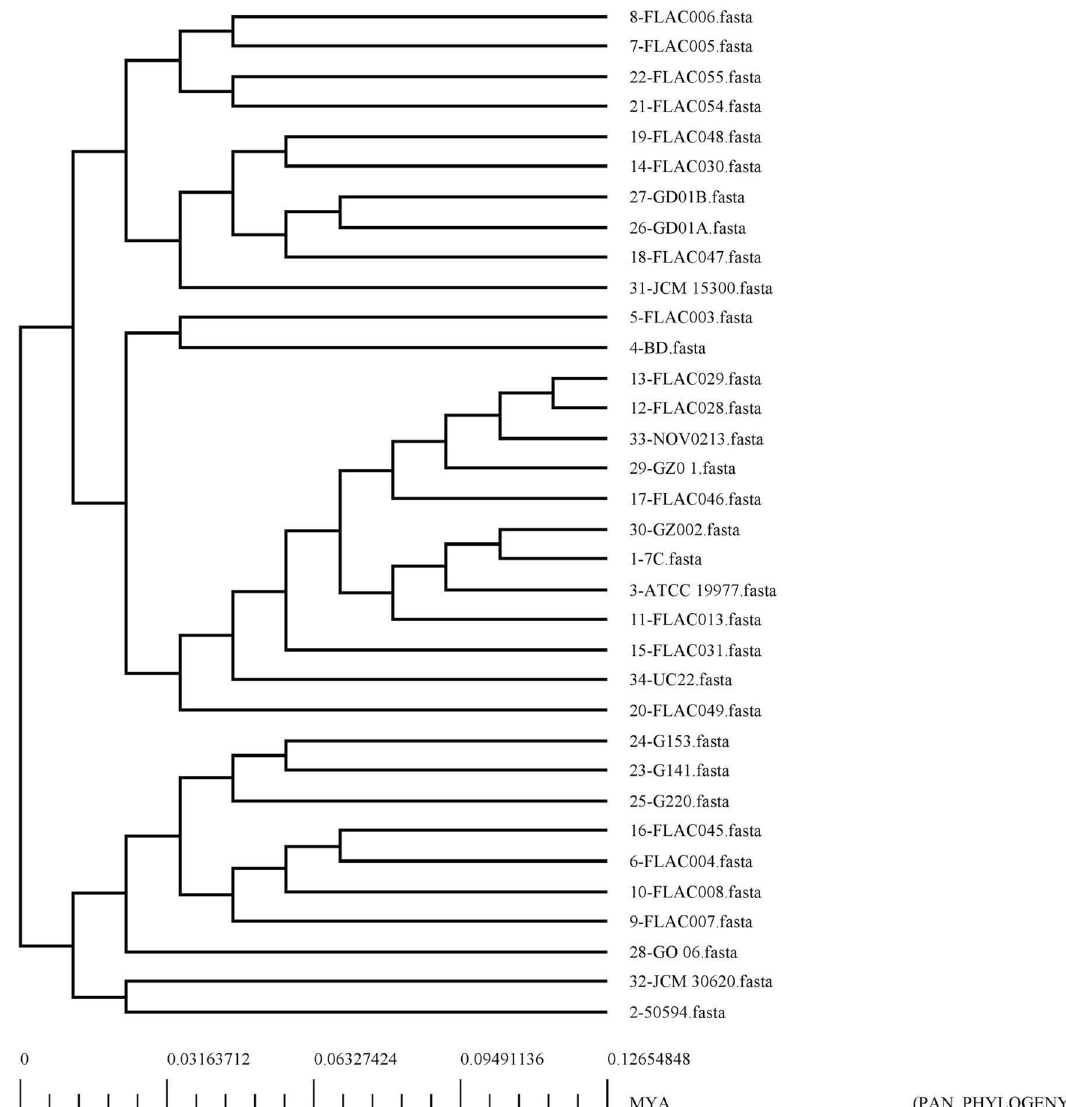
Figure 2. Panphylogeny tree of 34 complete genomes of Mycobacteroides abscessus . This pan-phylogeny has been constructed on the basis of accessory gene presence/absence data in different